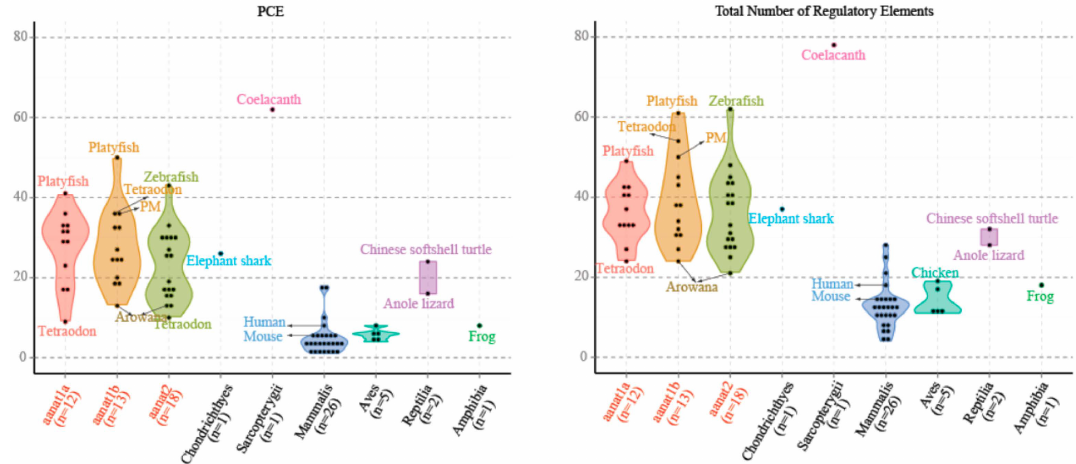
Figure 5. The numbers of PCE (Photoreceptor Conserved Elements) and the total numbers of regulatory elements (PCE, E-box, E-box-like, and PIPES, as defined in the Introduction) for different classes of aanat . We count aanat regulatory elements from 54 species, including those species mentioned in Supplementary Figure S1. The average number of aanat regulatory elements in fishes is larger than that of non-fish